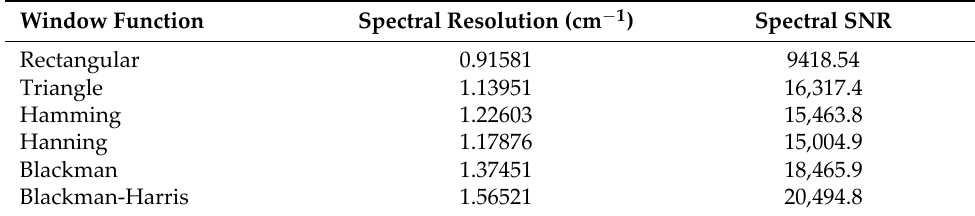
Table 5. Spectral resolution and SNR based on classical window functions.